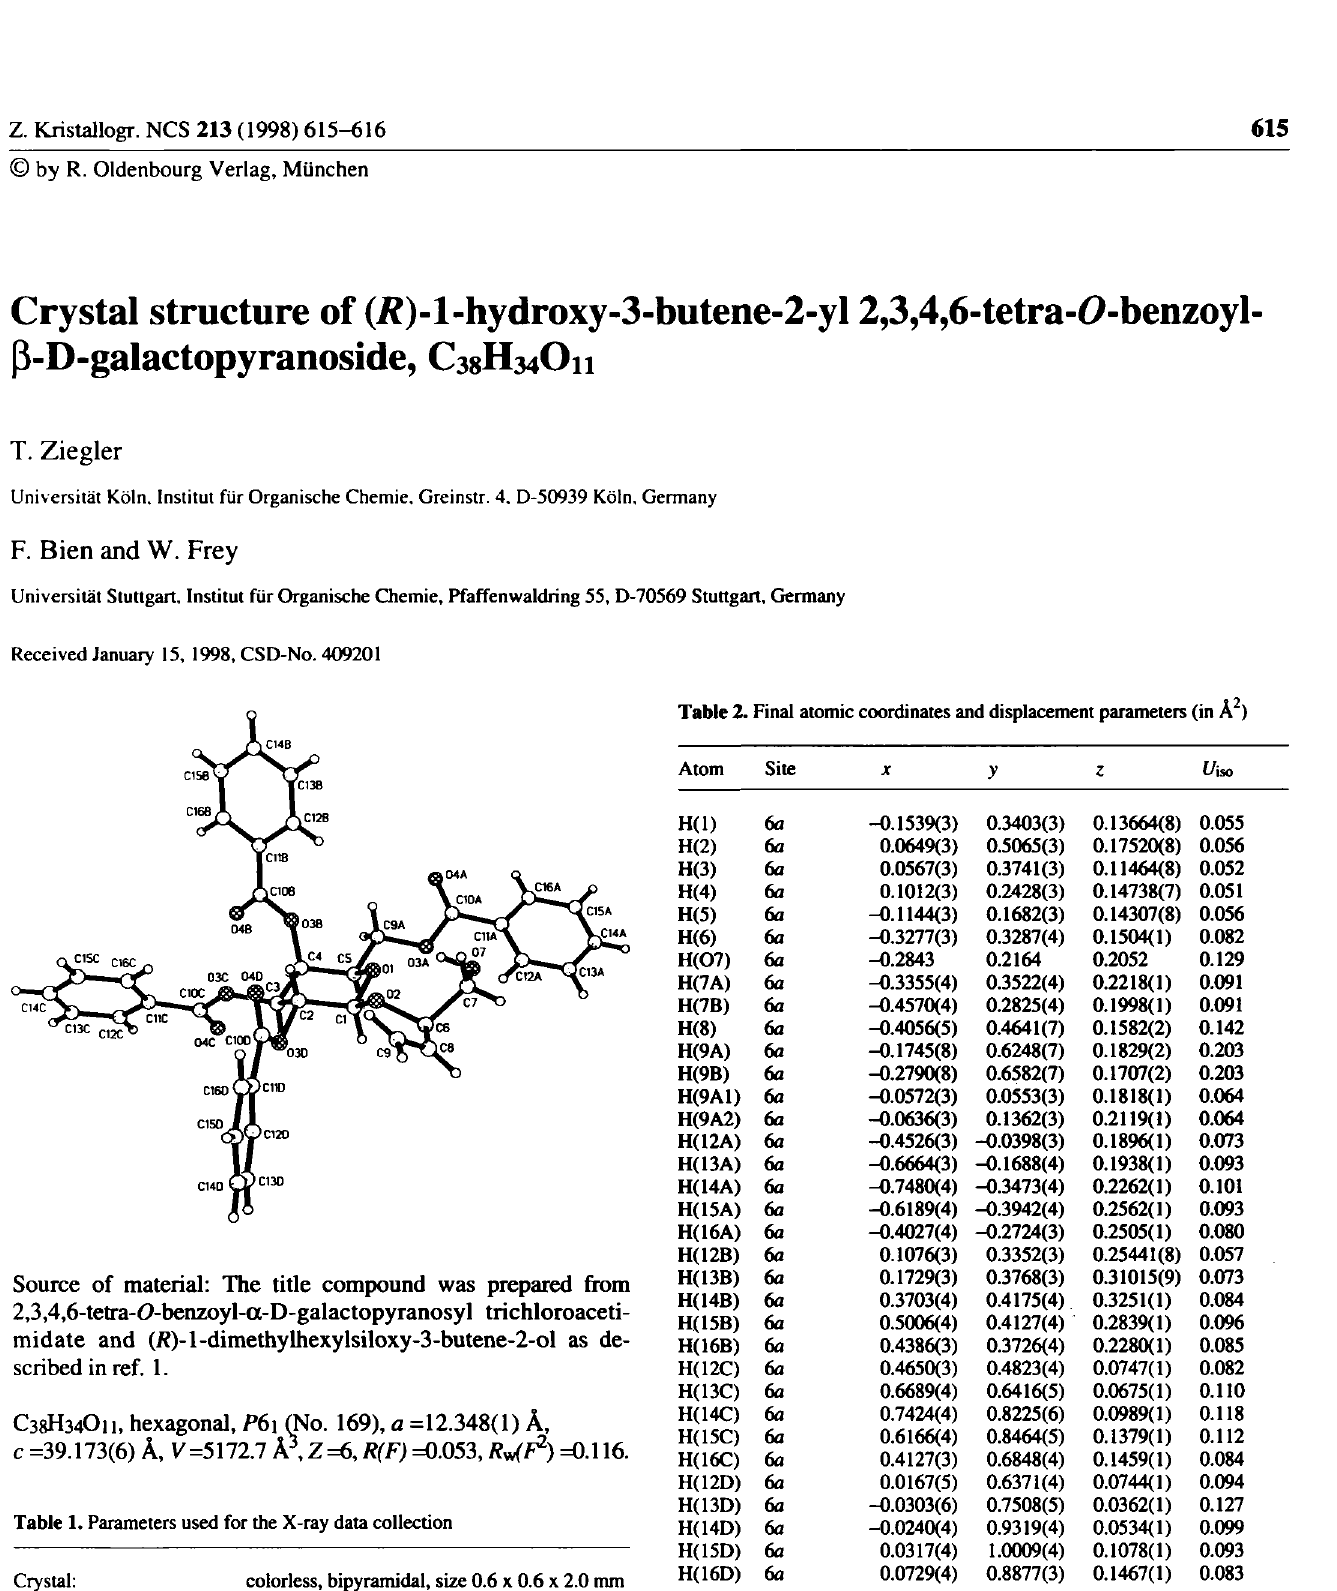
Table 1. Parameters used for the X-ray data collection